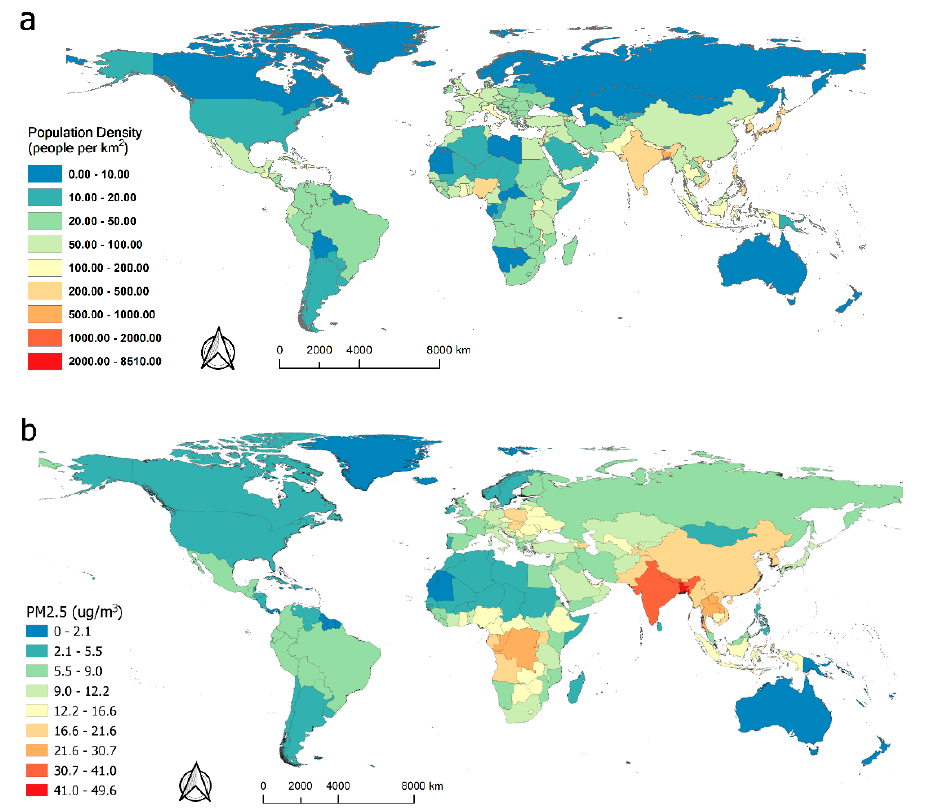
Figure 1. Global distribution of ( a ) population density and ( b ) PM 2.5 concentration.